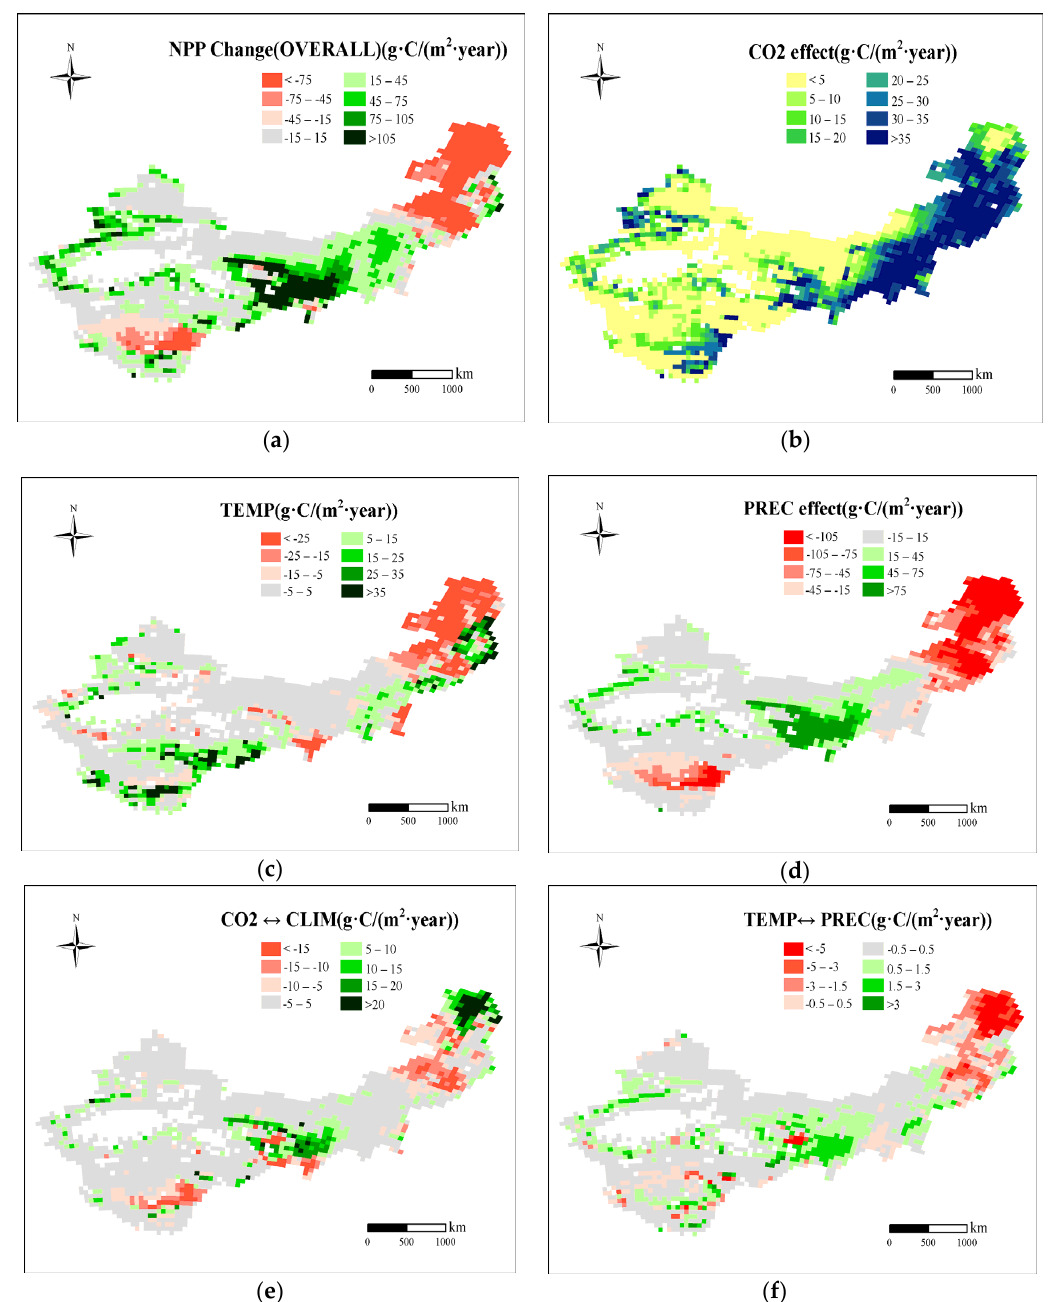
Figure 6. Spatial patterns of the NPP change (by comparing the mean NPP during the 1980–1997 period and 1997–2014) in response to changes in climate and CO 2 ( a ), and the contributions of the CO 2 fertilization effect ( b ), temperature change effect ( c ), precipitation change effect ( d ), and the interactive effects between CO 2 and climate changes ( e ) and between temperature and precipitation changes ( f ) to the NPP dynamics in ASA ‐ China, from1980–2014.